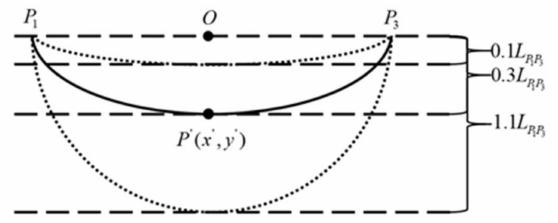
Figure 6. The detection of the quasi circle.